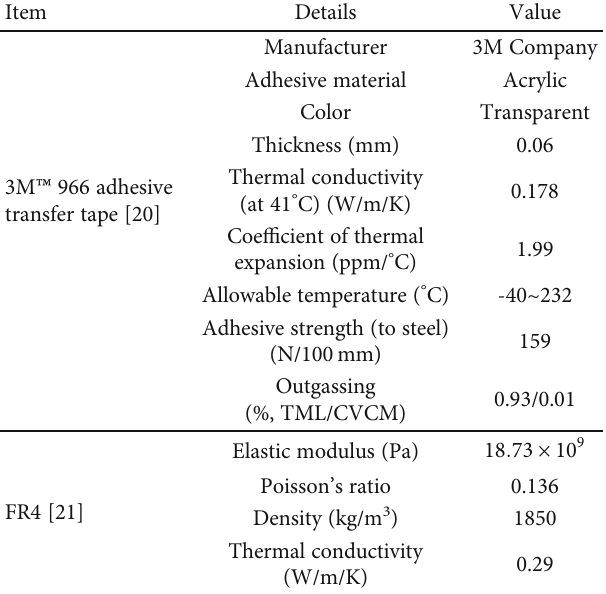
Table 1: Speci fi cation of materials used in the solar panel. Item